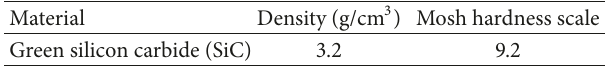
Table 2: The mechanical property of green silicon carbide [14].